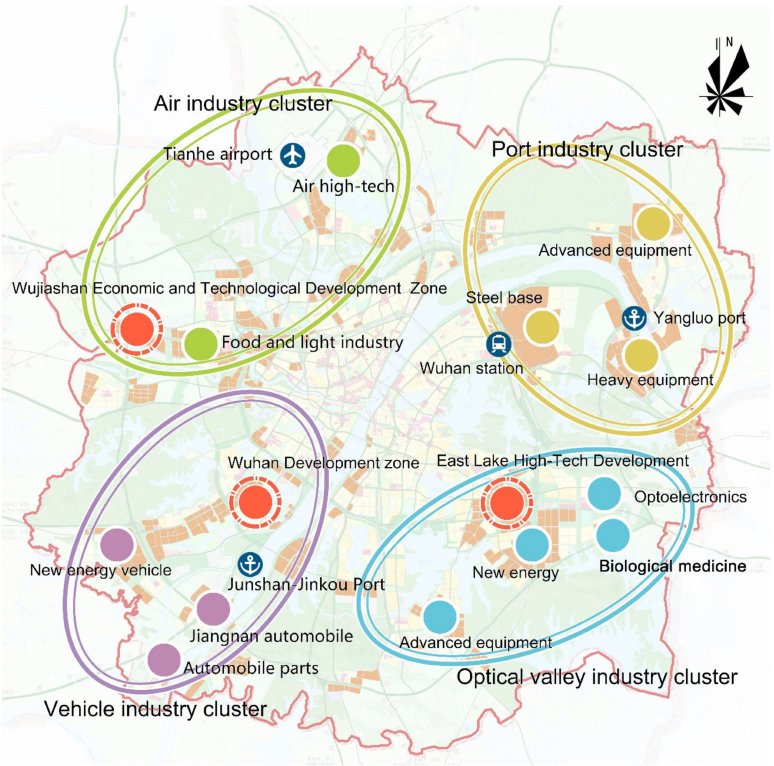
Figure 7. Distribution of industrial strategic areas in the Wuhan metropolitan